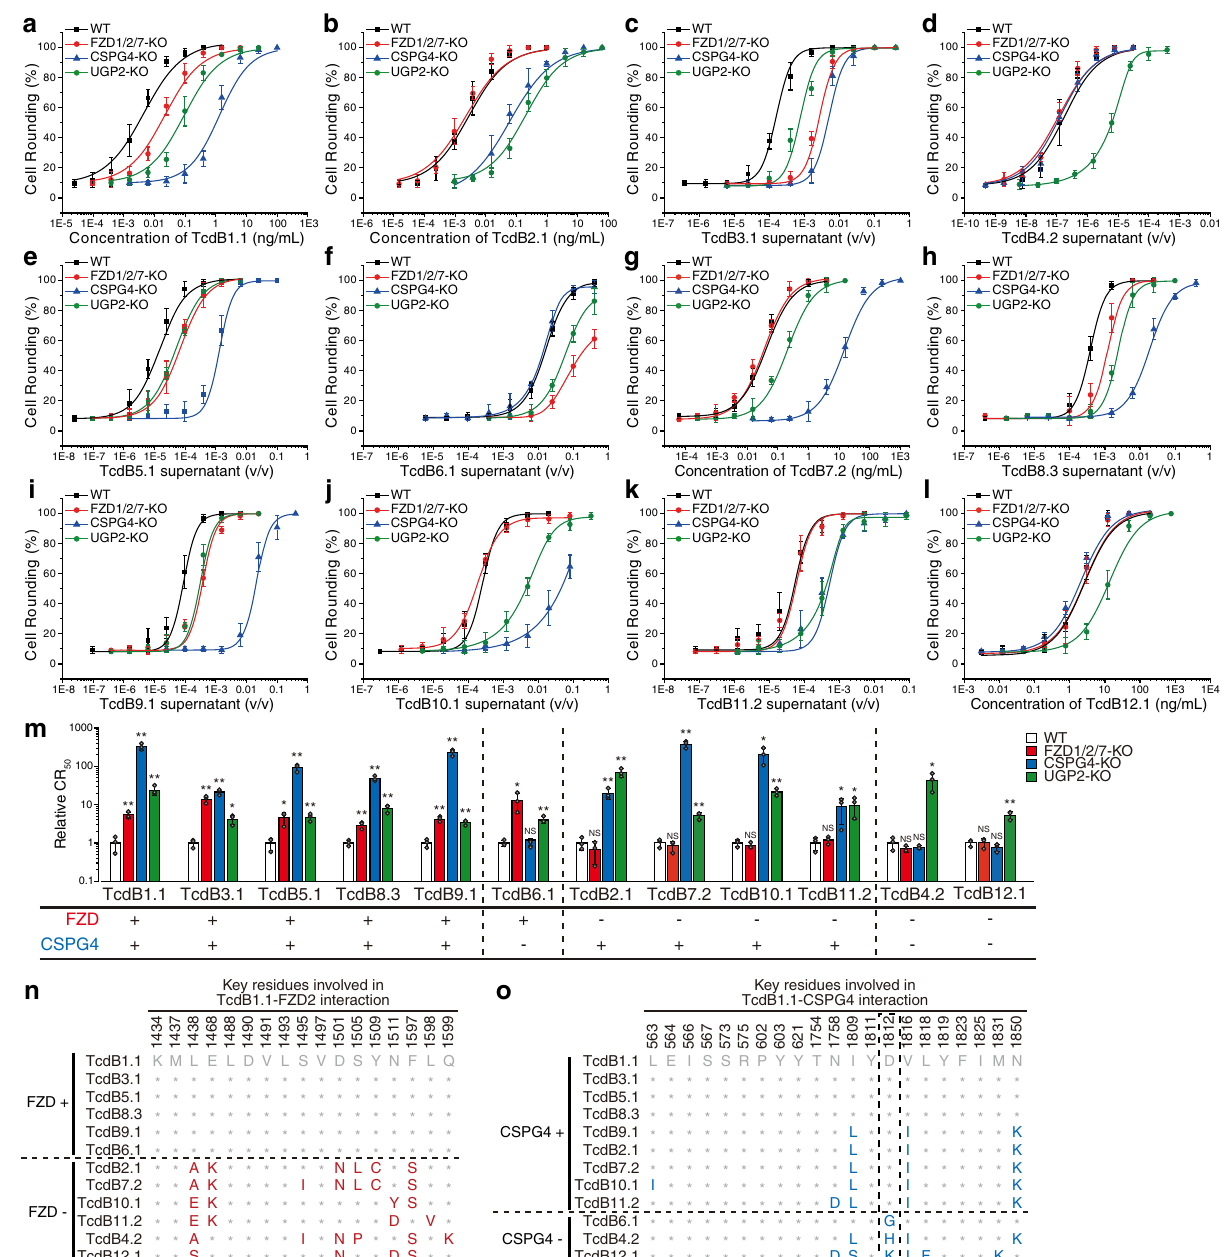
Fig.1|TcdBsubtypesshowvariabledependencyonFZDandCSPG4receptors. HeLa wildtype (WT), stable FZD1/2/7 knockout (FZD1/2/7-KO), CSPG4-KO, and UGP2-KO cells were exposed to either recombinant TcdB1.1 ( a ), TcdB2.1 ( b ), TcdB7.2( g ),and TcdB12.1 ( l ),or culturesupernatants from native C.dif fi cile strains